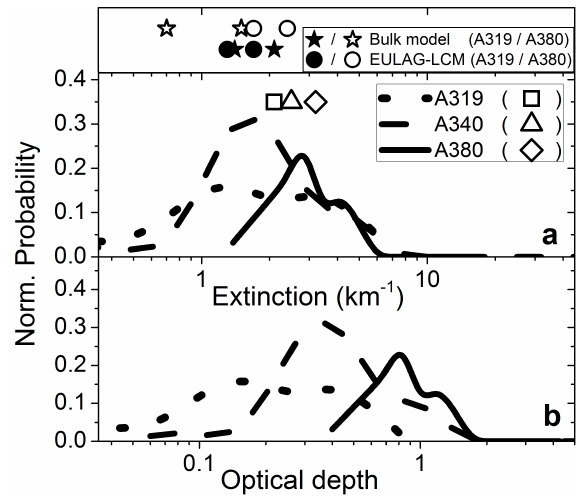
Fig. 5. Normalized frequency distributions of extinction (a) and optical depth (b) of the selected sequences from the A319, A340 and A380 contrails. Mean extinction values of the three aircraft are shown in (a) by empty symbols. Mean and maximum extinction and optical depth increase with increasing aircraft weight under simi- lar meteorological conditions. For comparison, the mean extinction values derived by EULAG-LCM and the bulk model are shown in the upper panel for the two airliners for 97% (103%) ambient RHI, with the lower values for 97% ambient